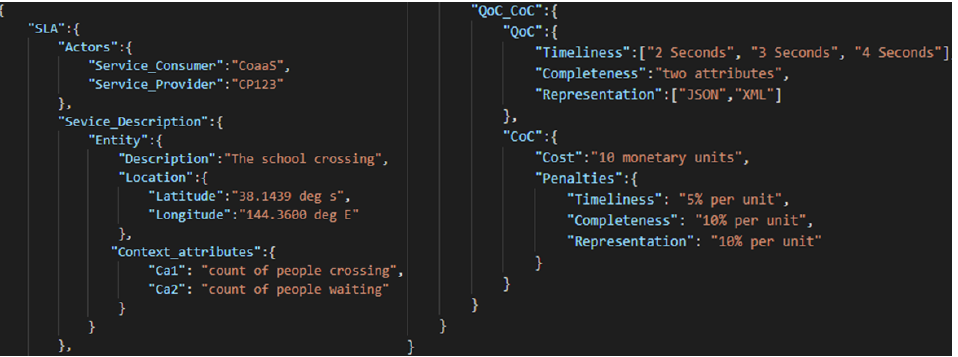
Figure 3. Code snippet of an example SLA template indicating its contents.